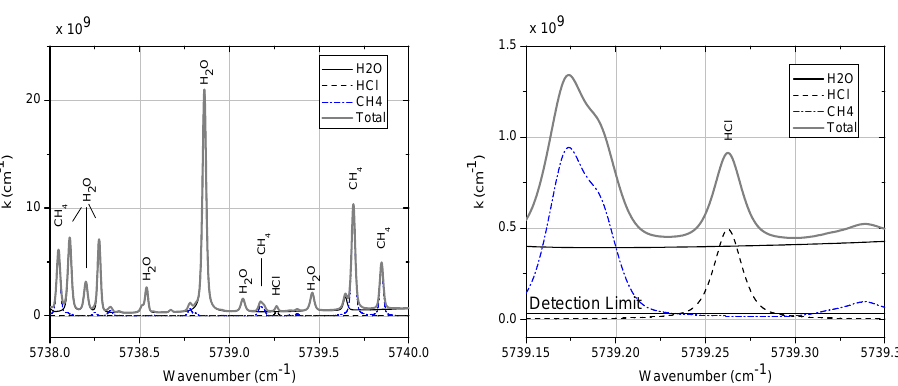
Fig. 2. Simulated absorption spectra in the vicinity of the targeted HCl absorption line. Simulated conditions are: P = 0.08bar, T = 295K, HCl = 0.5ppbv, CH 4 = 1.8ppmv, H 2 O = 0.013 (50% Relative Humidity). Left/Right: Zoomed out/in of HCl line.